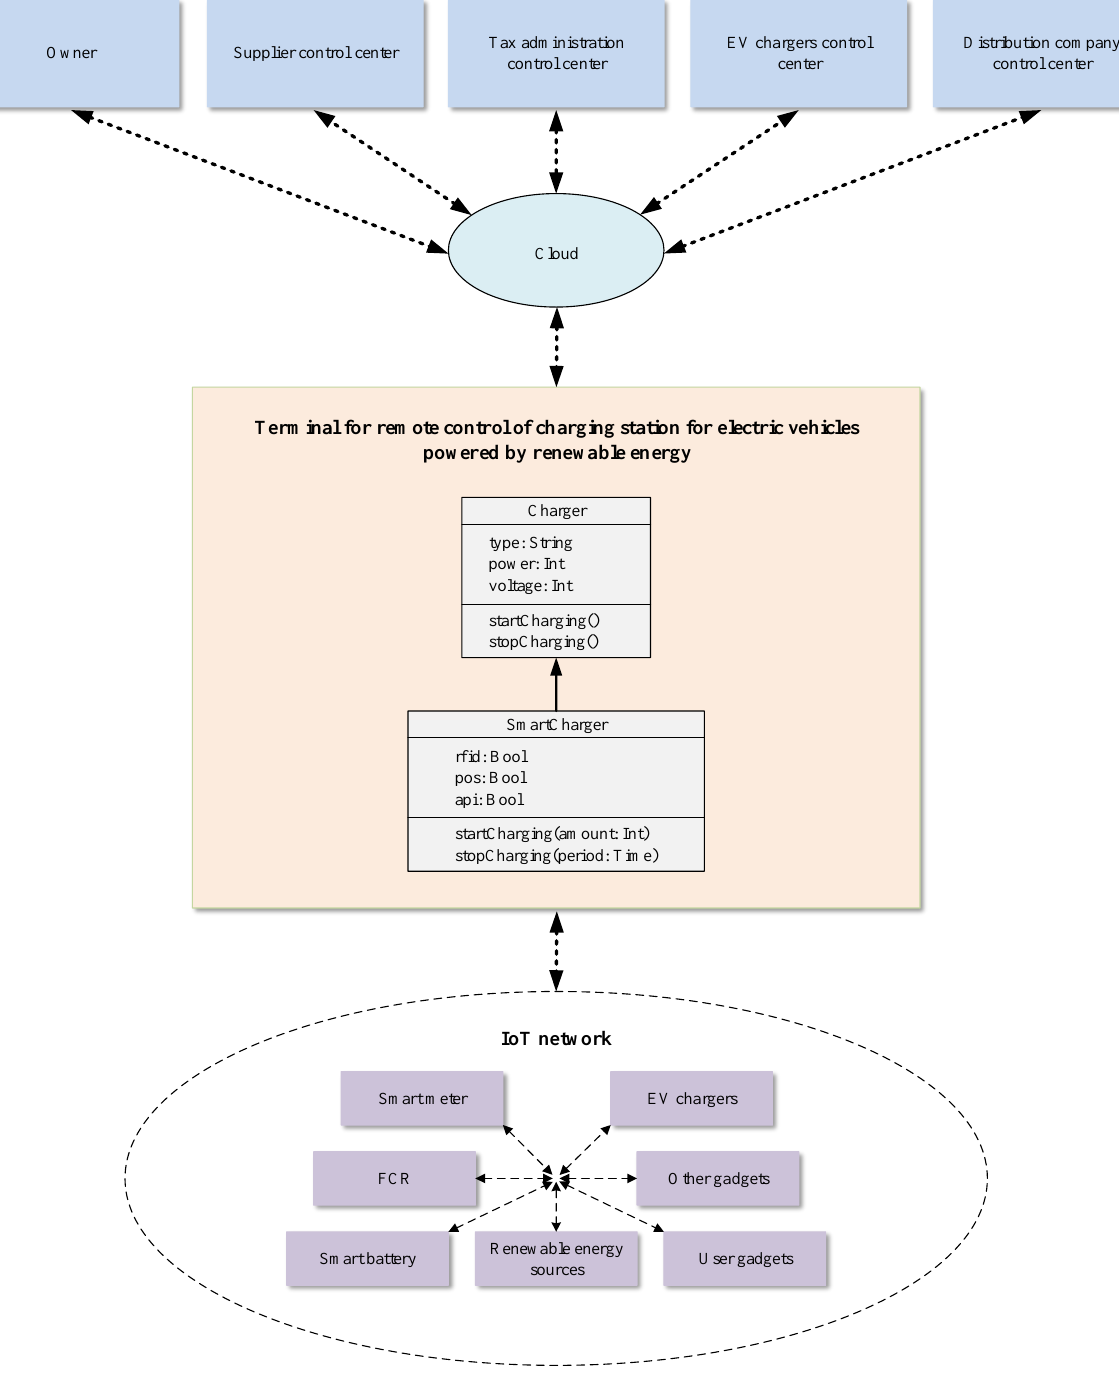
Figure 1. Block schematic of the design of the system for remote control of charging station for electric vehicles powered by renewable energy.